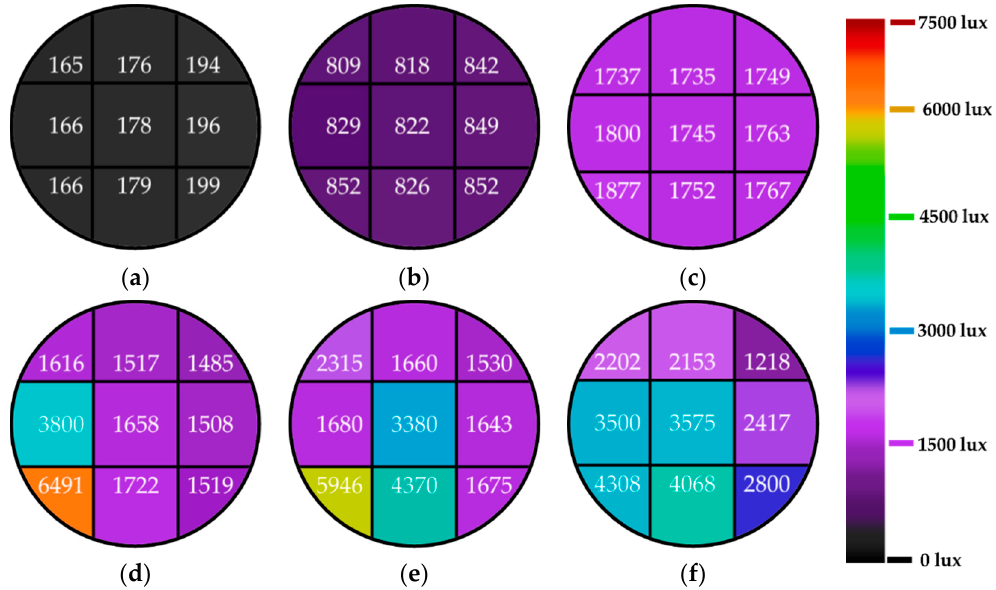
Figure 5. Illumination contours from zinc alloy light tube on the top end at the incident angles of ( a ) 0°, ( b ) 15°, ( c ) 30°, ( d ) 45°, ( e ) 60°, and ( f ) 75°.